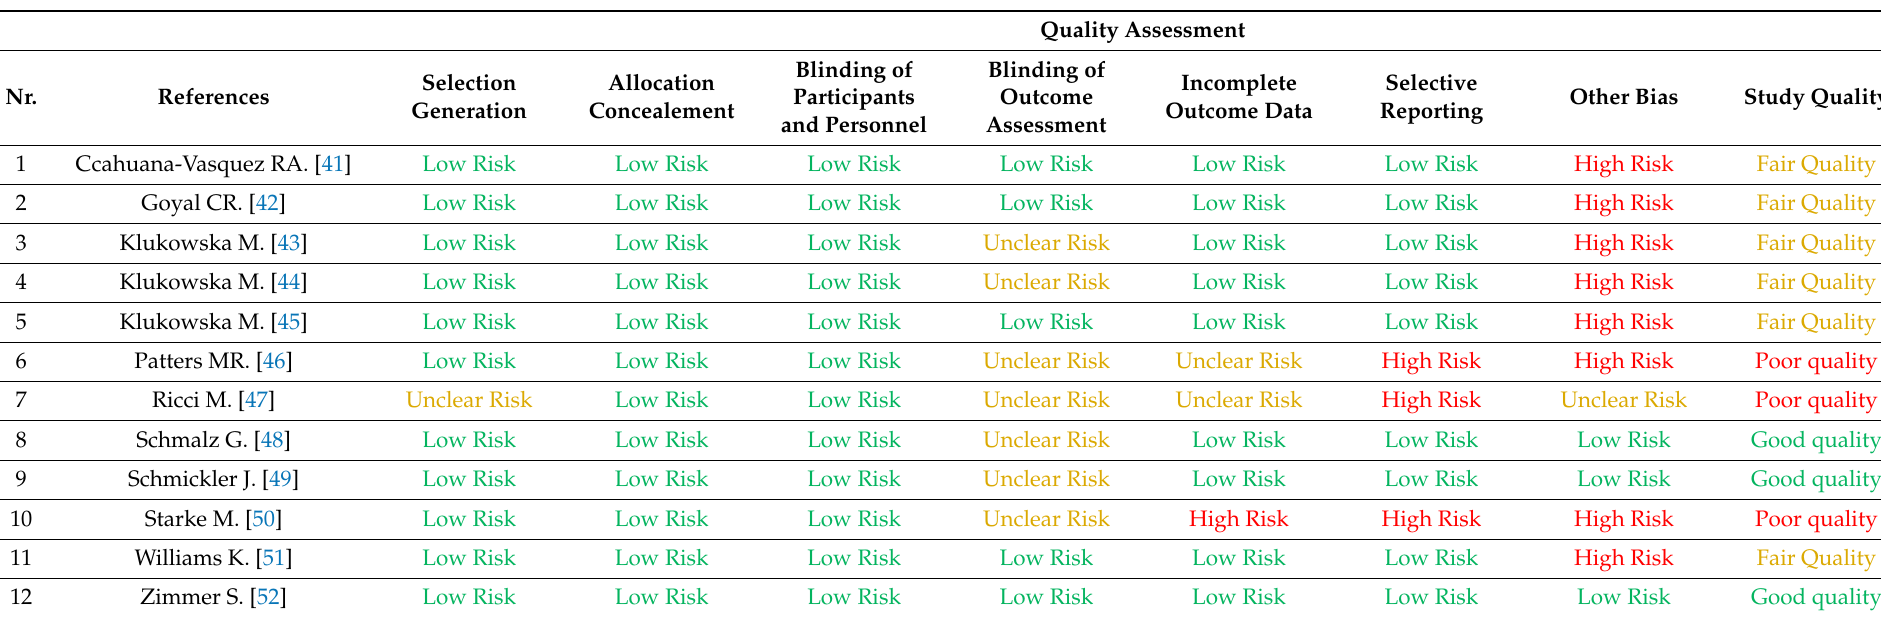
Table 5. Quality assessment: The methodological quality was assessed using the colors green, yellow, and red if the study is respectively with low risk, fair quality, or high risk, as suggested by the Cochrane Handbook in 2011